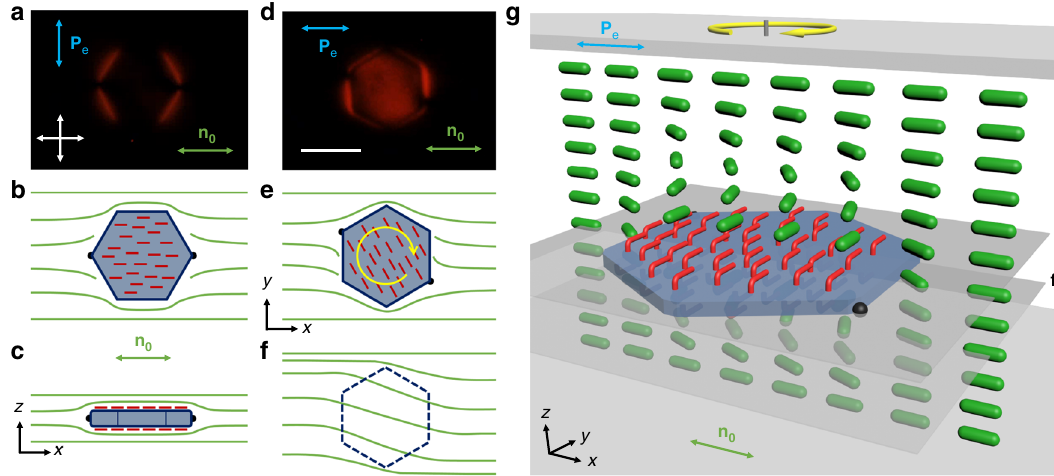
Fig. 1 Colloidal platelet with self-assembled azobenzene monolayers in a nematic liquid crystal. a polarizing optical micrograph obtained under red imaging light when the platelet is illuminated by linearly polarized blue light with P e ⊥ n 0 (green double arrows). P e is indicated by a blue double arrow and crossed polarizers of the microscope are shown using white double arrows. b , c corresponding schematics of n ( r ) (green lines) and orientations of trans-state azobenzene moieties (red rods) within the self-assembled monolayers b , in the plane parallel to cell substrates ( xy plane) and c in the cell ’ s vertical cross- section ( xz plane). Black fi lled hemi-circles at the vertices of platelet along n 0 depict the boojum defects. d Polarizing micrograph of the same particle as in a , but when it rotates under blue-light illumination with P e || n 0 . Scale bar is 5 µ m. e , f Schematics of n ( r ) and azobenzene orientations in the plane of platelets e , and in the plane beneath it f , both marked in g ; the circular yellow arrow shows handedness of rotation. g Three-dimensional schematic of the self-assembled molecular-colloidal light-driven motor between two con fi ning glass plates, with the green rods represent LC molecule and the azobenzene molecules of self-assembled monolayers shown in